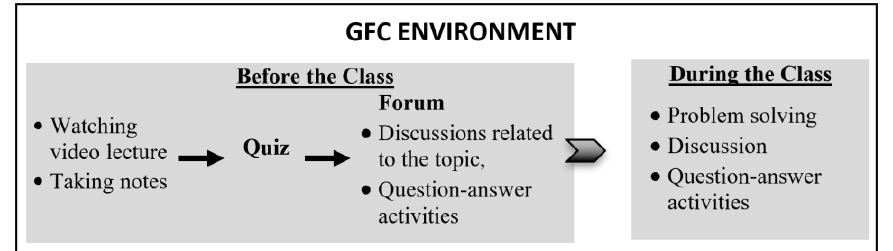
Fig. 2. The experimental group study